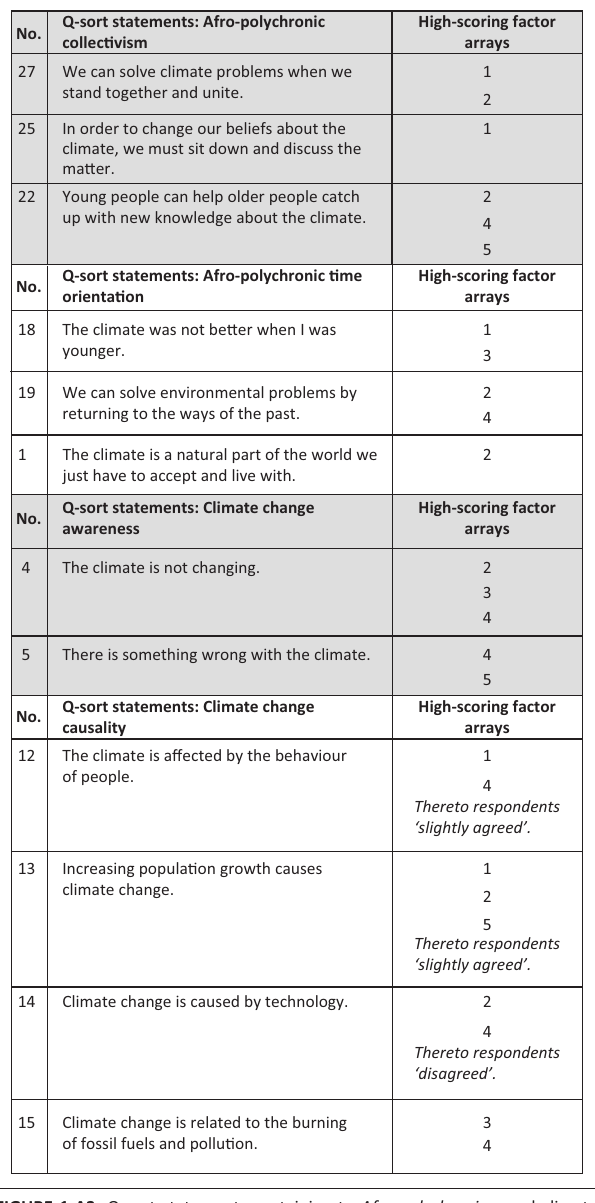
FIGURE 1-A3: Q-sort statements pertaining to Afro-polychronism and climate